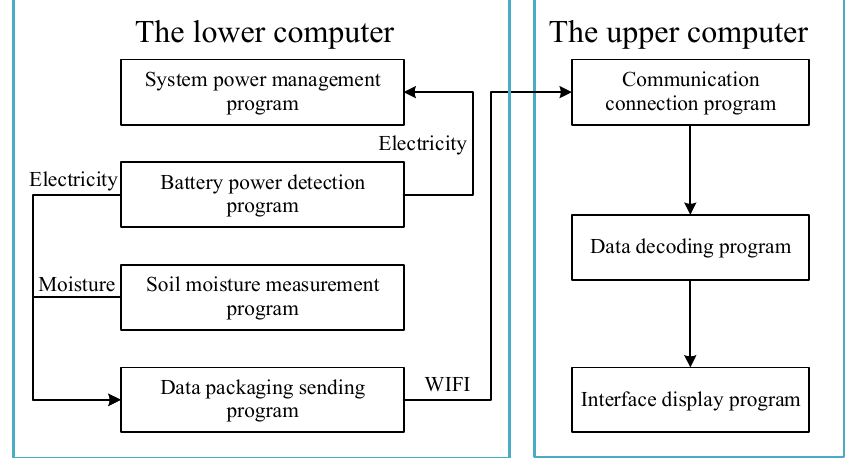
Figure 8. Block diagram of the system software.